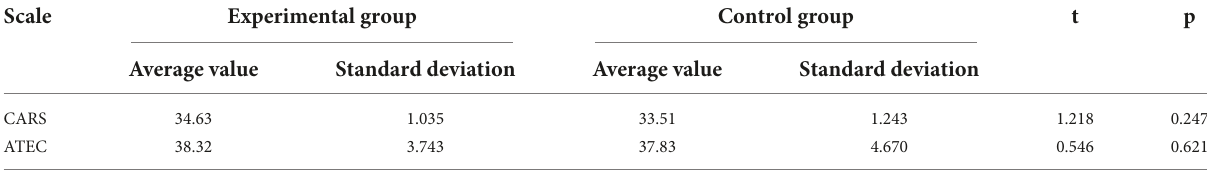
TABLE 2 Independent sample t -test results of CARS and ATEC pre-test scores in experimental group and control group.